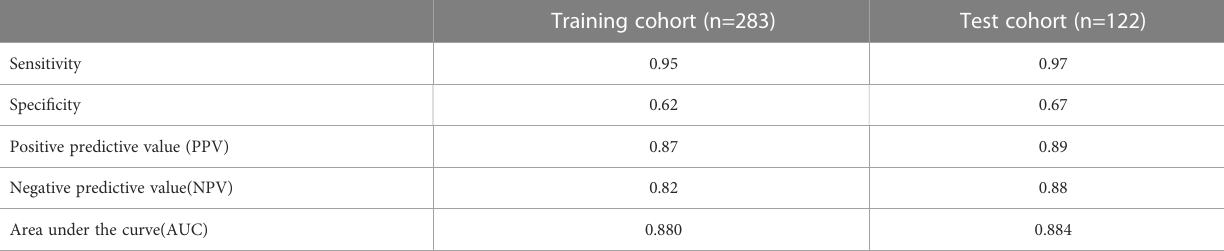
TABLE 3 The DLCT-based Nomogram Performance